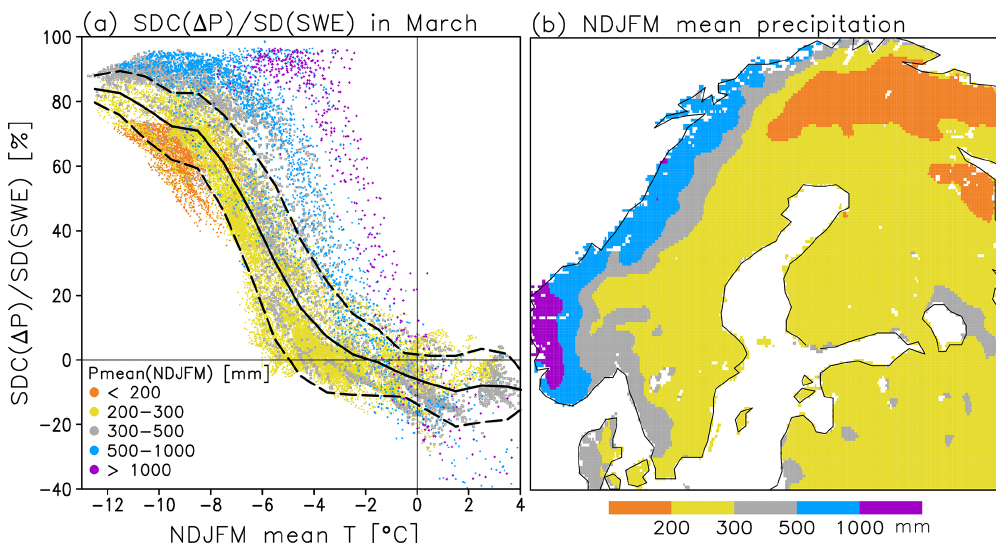
Figure 8. (a) The relative contribution of precipitation anomalies to the standard deviation of SWE in March as a function of the NDJFM mean temperature in 1981/82–2019/20. Each dot represents a single 0.1 ◦ × 0.1 ◦ grid cell, coloured according to the mean NDJFM precipitation shown in (b) . The solid line in (a) indicates the mean values for 1 ◦ C temperature bins, and the two dashed lines indicate the mean ± 1 standard